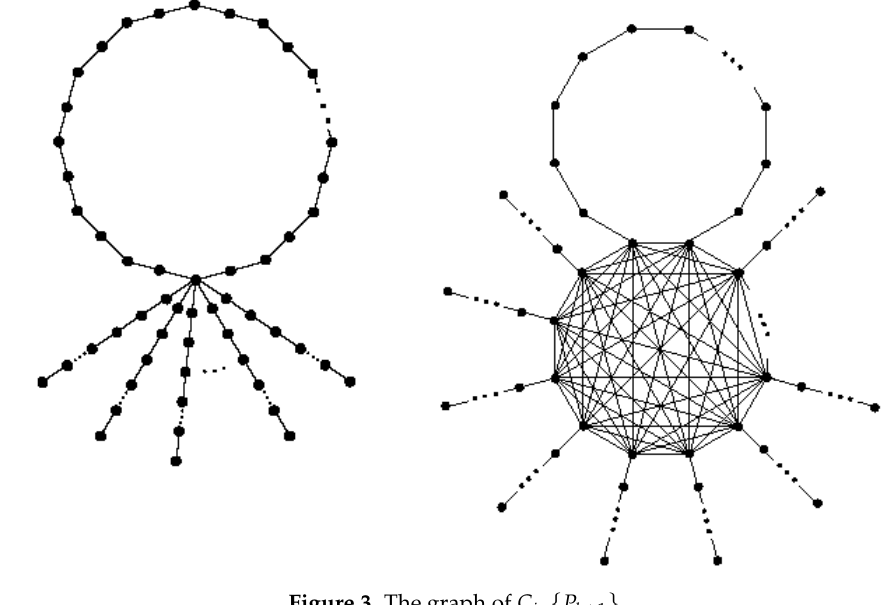
Figure 3. The graph of C i , r { P k + 1 }